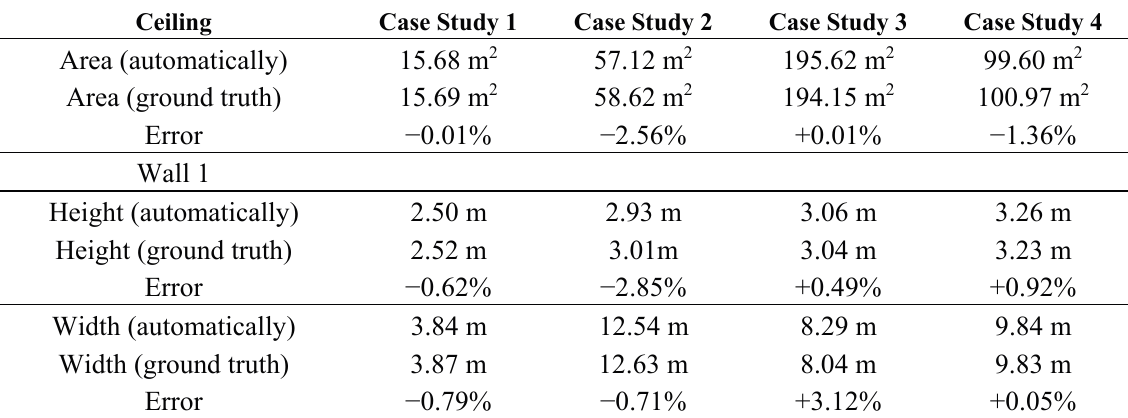
Table 5. The results of geometric quality analysis of building envelope